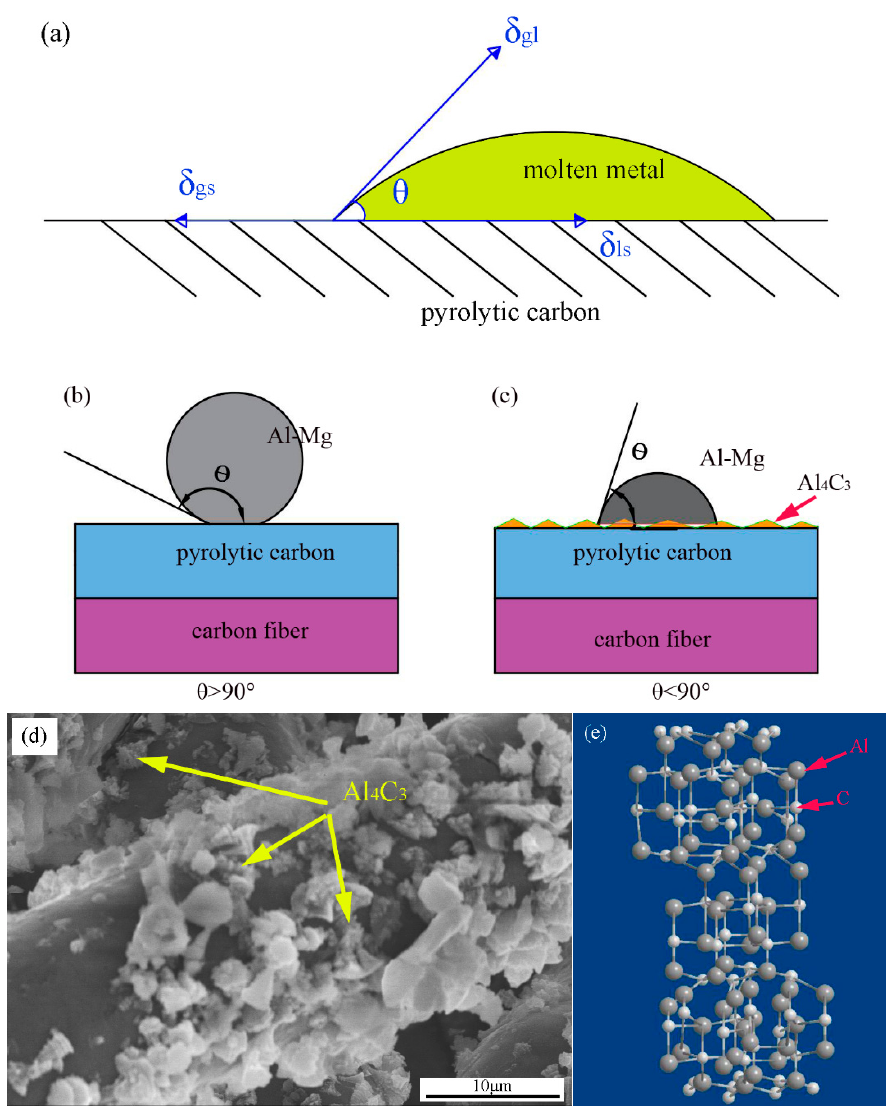
Figure 11. The wetting model and the crystal structure of Al 4 C 3 . ( a ) The relationship between the angle of infiltration and tension; ( b ) Wettability angle ( θ > 90°); ( c ) Wettability angle ( θ < 90°); ( d ) Al 4 C 3 particles; ( e ) The crystal structure of Al 4 C 3.